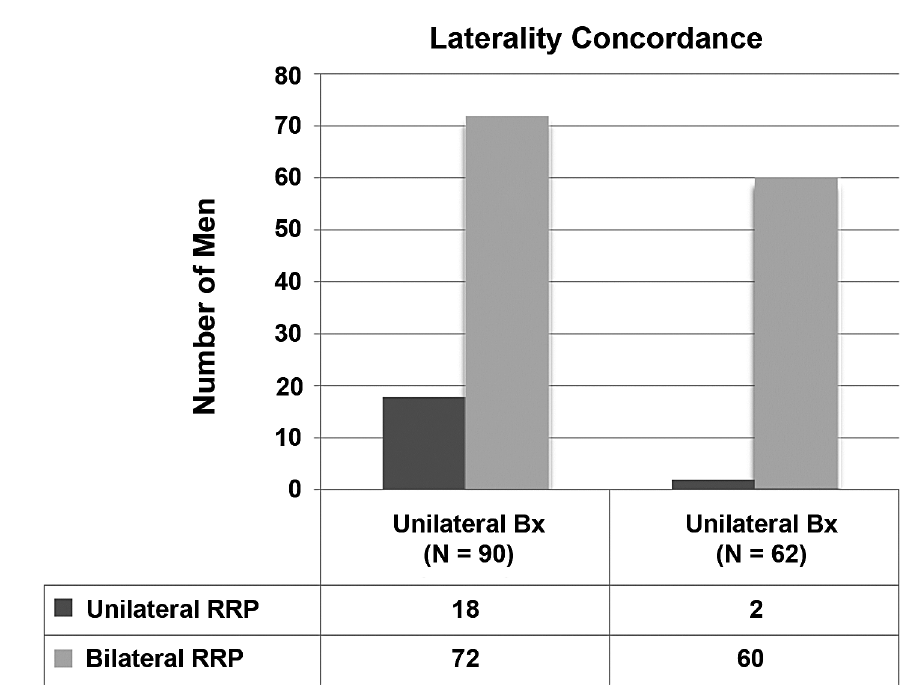
Figure 2 – Laterality concordance on radical retropubic prostatectomy